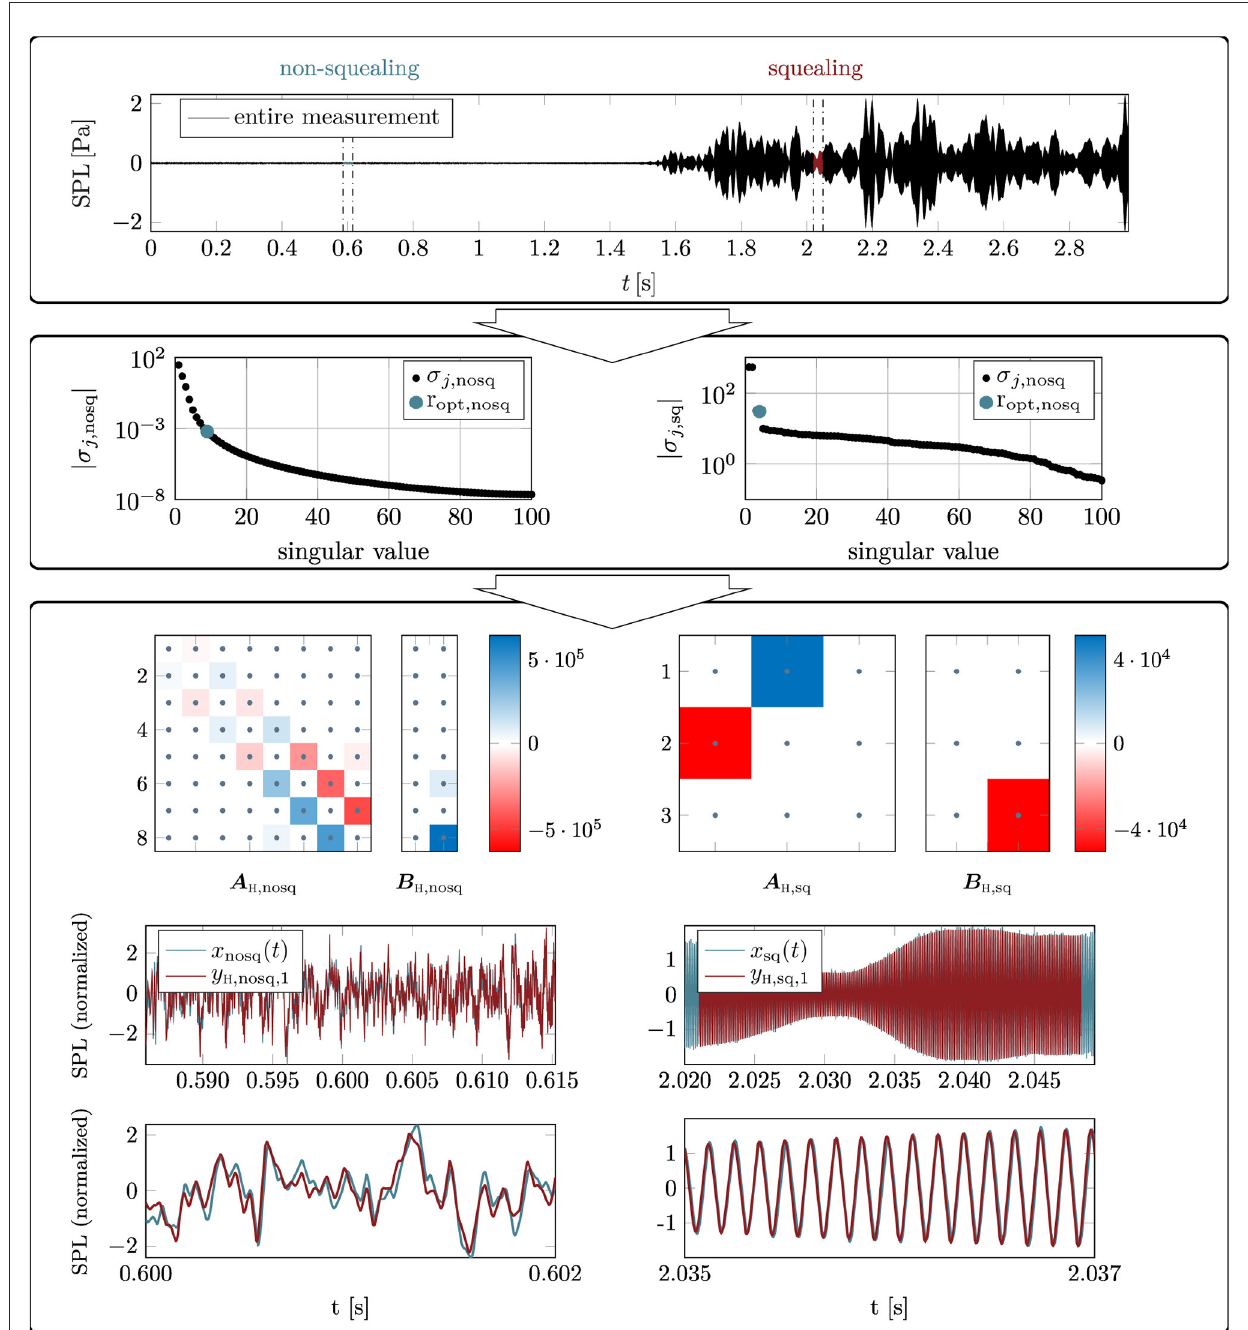
FIGURE10 Application of the HAVOK algorithm to real-world measurement data. The sound pressure level (SPL) obtained with a microphone during the actuation of the friction brake of a passenger car is shown on the top. The dash-dotted lines indicate the sections from the silent and squealing regime used as input to the HAVOK algorithm. The singular values for each regime are visible in the center panel. In the bottom panel, the HAVOK model state matrices A H and the input matrices B H are shown, along with the resulting time series y H,1 ( t ) compared to the input time series x ( t ). As before, both time series are normalized to have zero mean and a standard derivation of